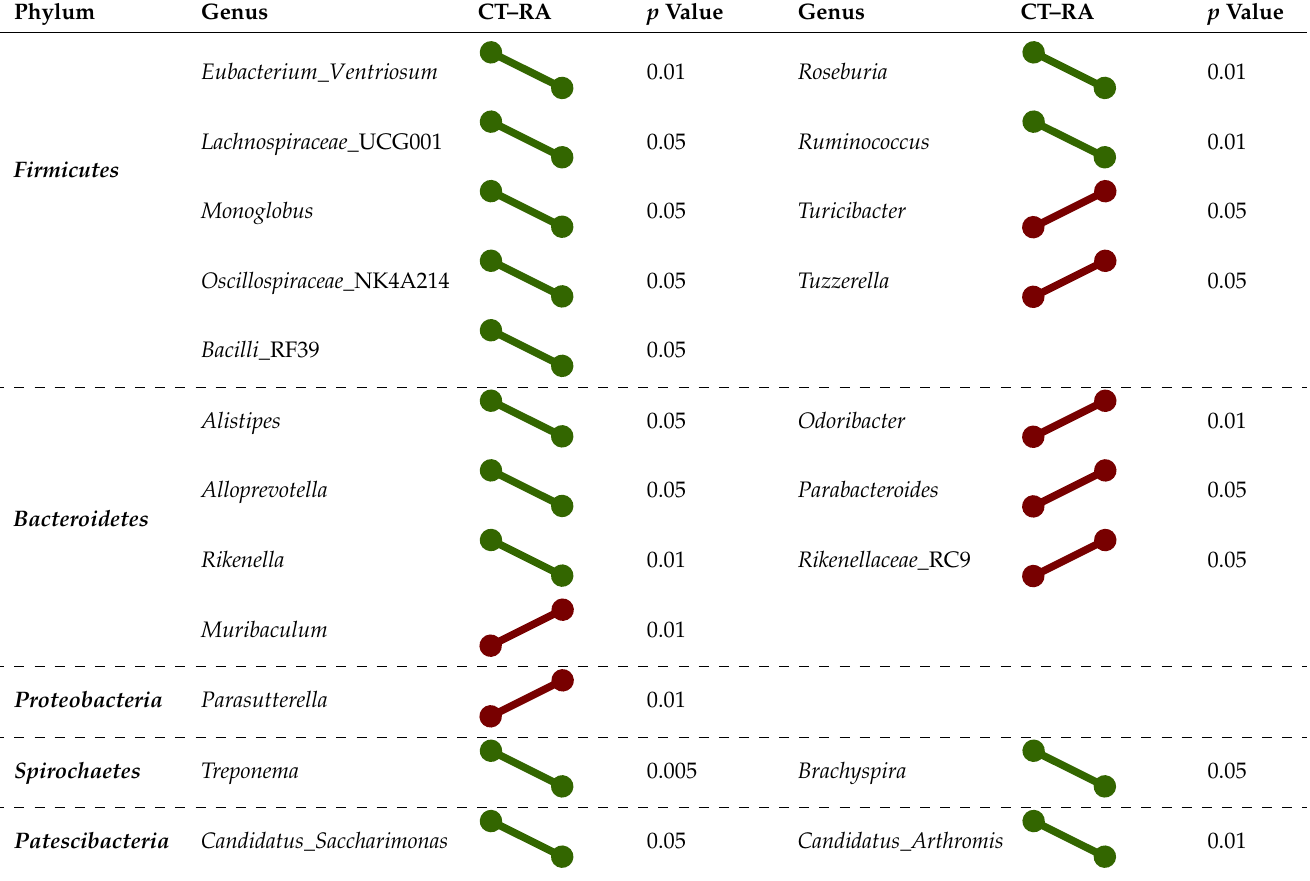
Table 3. Composition of the fecal microbiome at weeks 1–12.